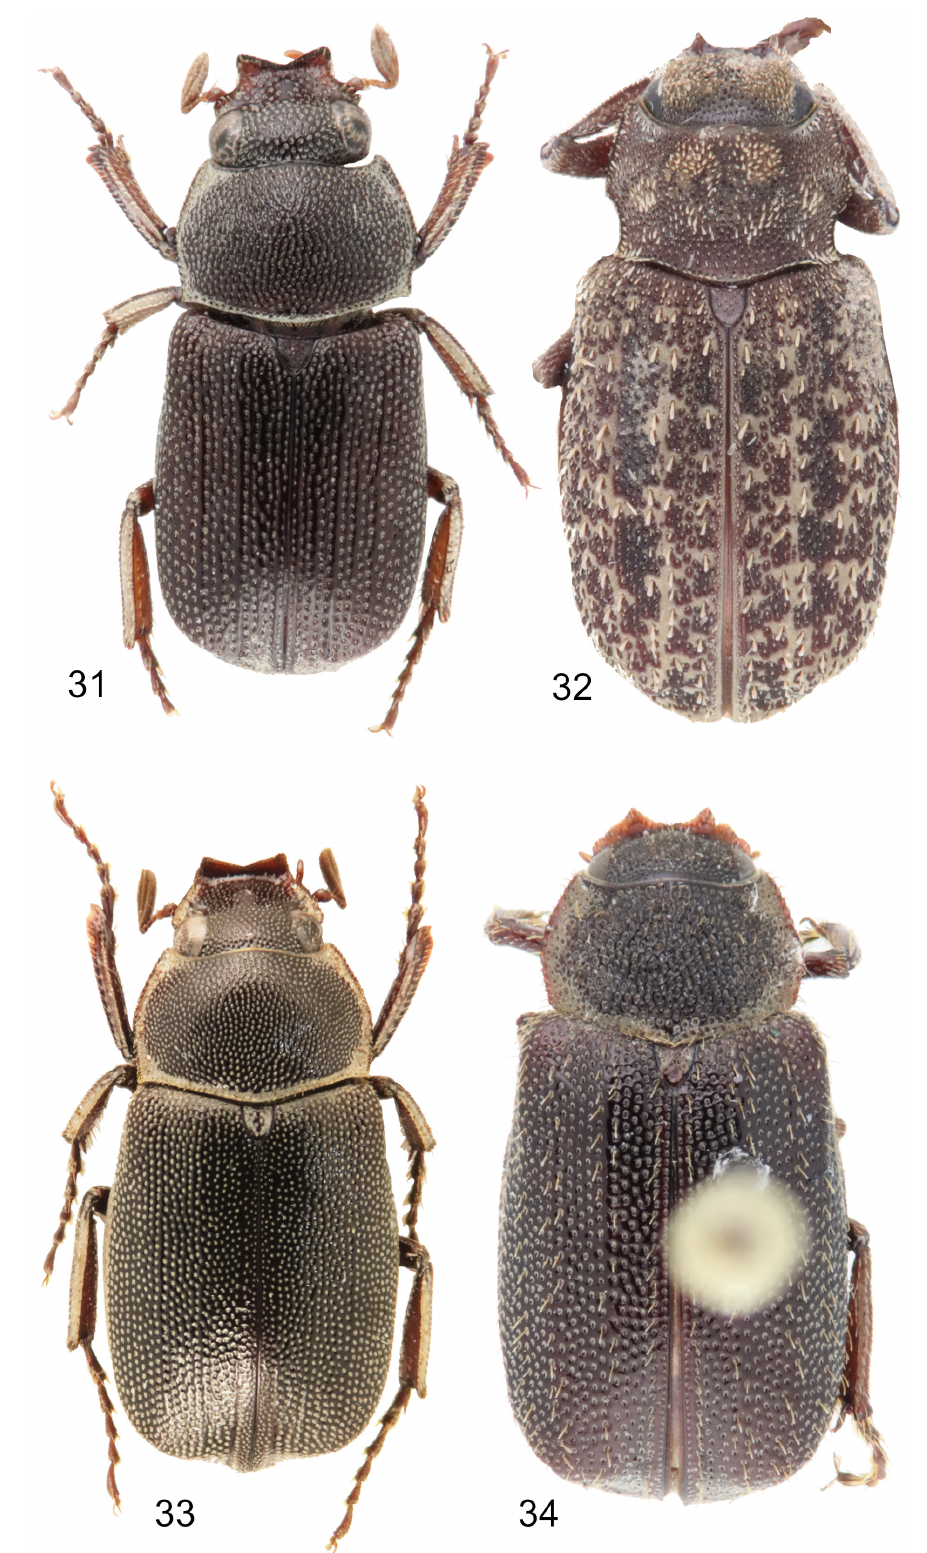
Figs 31–34. Papuan and Wallacean Maechidius Macleay, 1819, habitus, dorsal view. 31 . M. ciliatus sp. nov., holotype, ♂ (IECA). 32 . M. crypticus sp. nov., paratype, ♂ (BMNH). 33 . M. dani sp. nov., holotype, ♂ (IECA). 34 . M. deltouri sp. nov., holotype, ♂ (BMNH). Not to